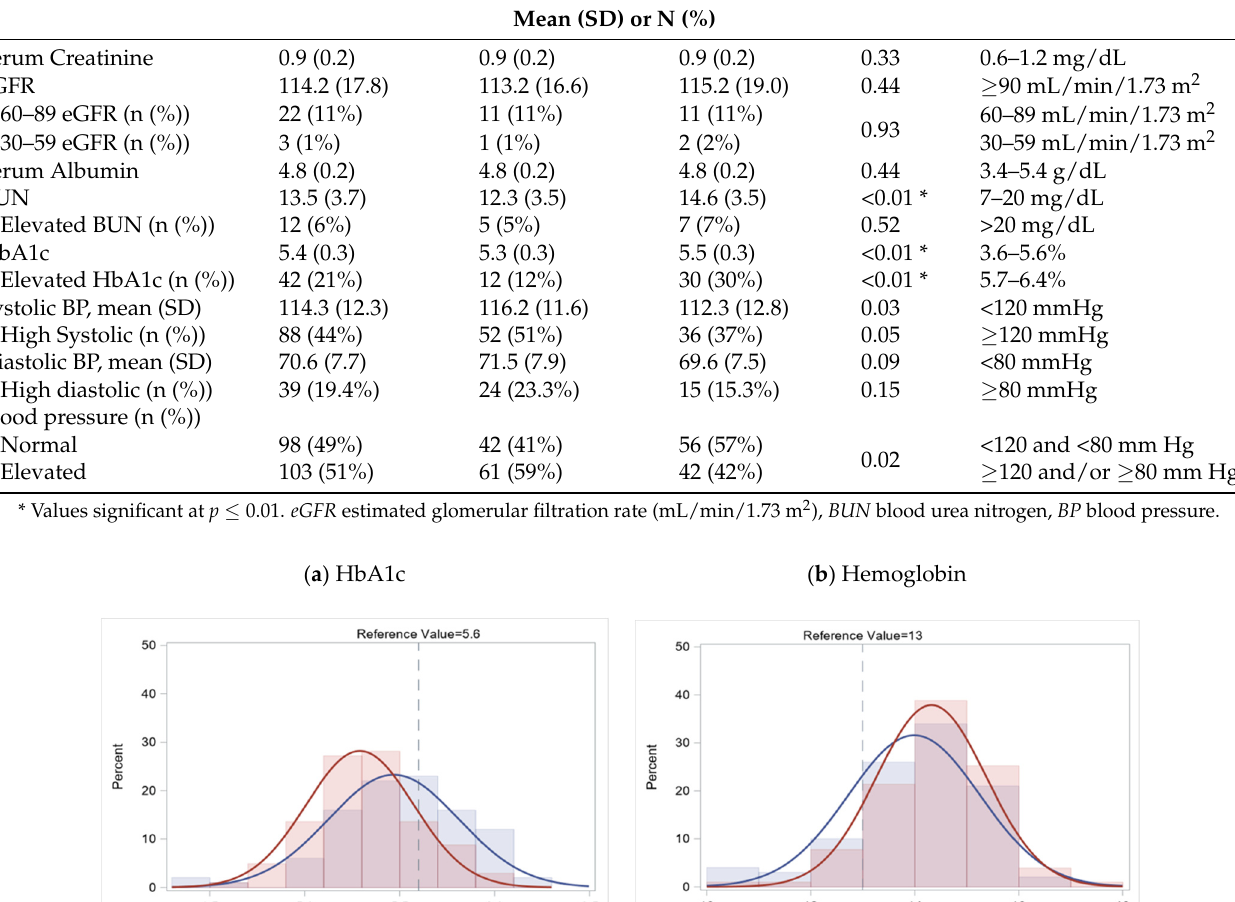
Table 2. Markers of underlying health among participants, mid-harvest, January 2019.